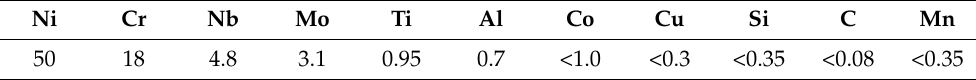
Table 2. Chemical composition of Inconel 718